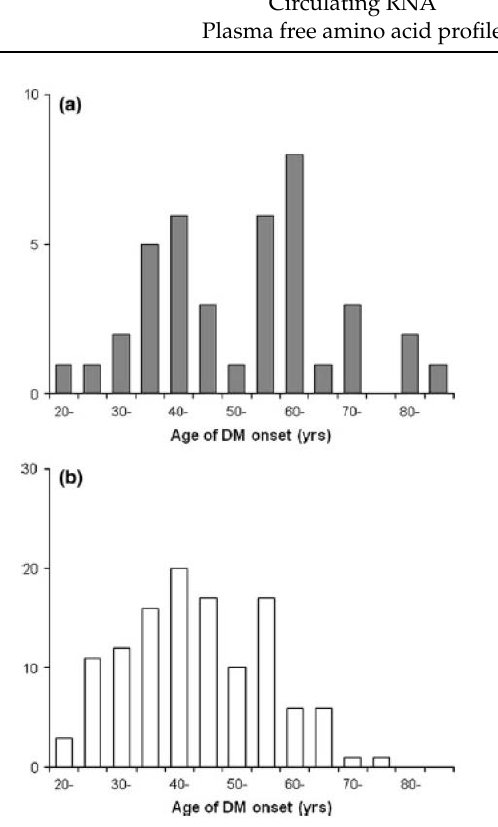
Figure 3. Age distribution of diabetes mellitus (DM) onset ( a ) in diabetic patients with pancreatic cancer and ( b ) in diabetic patients without pancreatic cancer. This figure is adopted from Mizuno S et al.